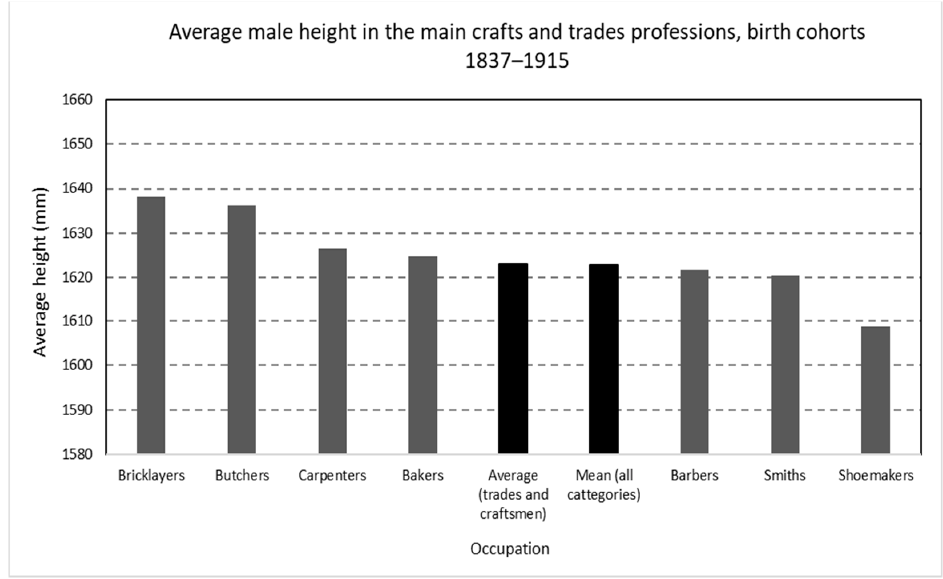
Figure 5. Average male height in the main crafts and trades professions, birth cohorts 1837–1915 (Source: calculated with data from the Expedientes .).